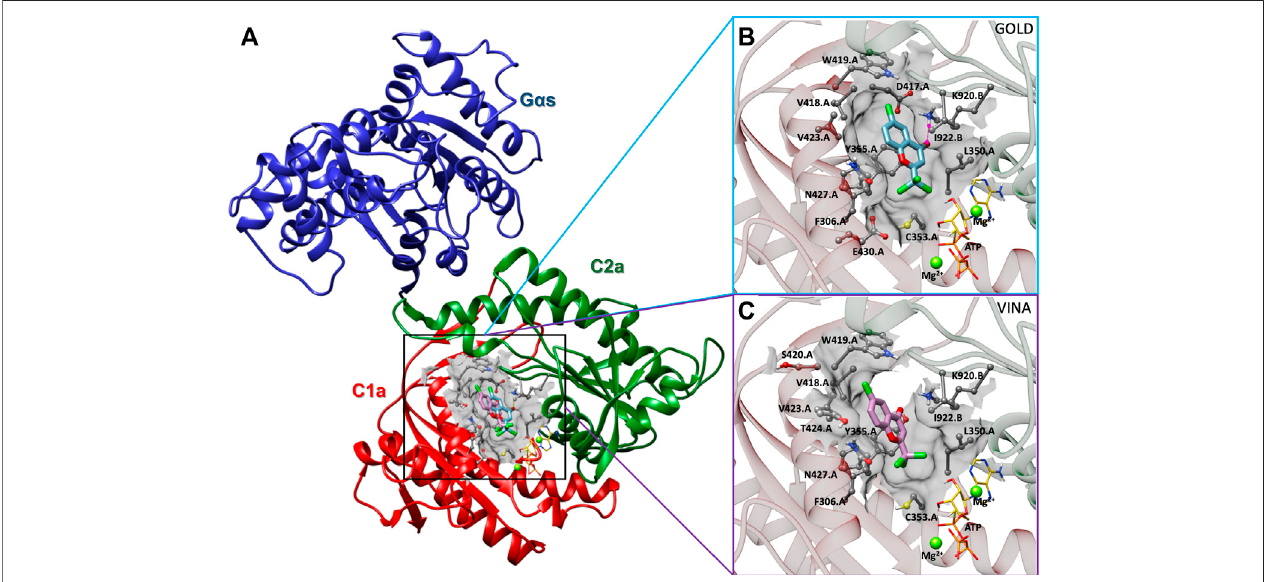
FIGURE5| PredictionoftheinteractionbetweenAC1andST034307. (A) CartoonrepresentationoftheAC1model,showingitscatalyticdomain (C1a,inred,and C2a, ingreen) complexed toG α s (in blue), ST034307 (in cyan orpurple),ATP(in yellow), and twomagnesium ions(Mg 2+ ,ingreen).Predictedposes ofST034307, using Gold (B) and Autodock Vina (C) programs, presenting hydrogen-bond(interruptedpurpleline)and steric interactions. TheAC1 residuestructuresareshown asballand stick models, ST034307 and ATP as stick models, and Mg 2+ ions as sphere models using UCSF Chimera program (Pettersen et al., 2004). All the structures are coloredbyatom:thenitrogen atoms areshown inblue, theoxygen atomsinred,thechlorine atomsingreen,thehydrogen atoms inwhite,andthecarbon chainingray, cyan, or purple. Non-polar hydrogens have been omitted for clarity.